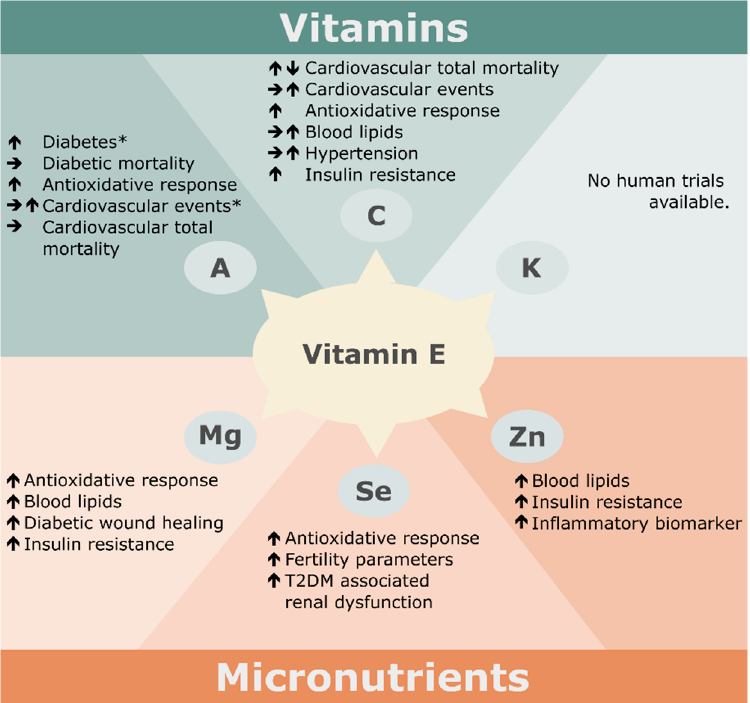
Figure 2. Impact of the dietary intake or the supplementation of vitamin E and other micronutrients including vitamins A (including β -carotene), C, and K, as well as zinc, magnesium, and selenium, on metabolic diseases. ↑ , improved parameter after co-supplementation; ↓ , deteriorated parameter after co-supplementation; → / ↑ , controversial results found in different trials; *, correlation shown by observational studies. Abbreviation: T2DM, diabetes mellitus type 2.